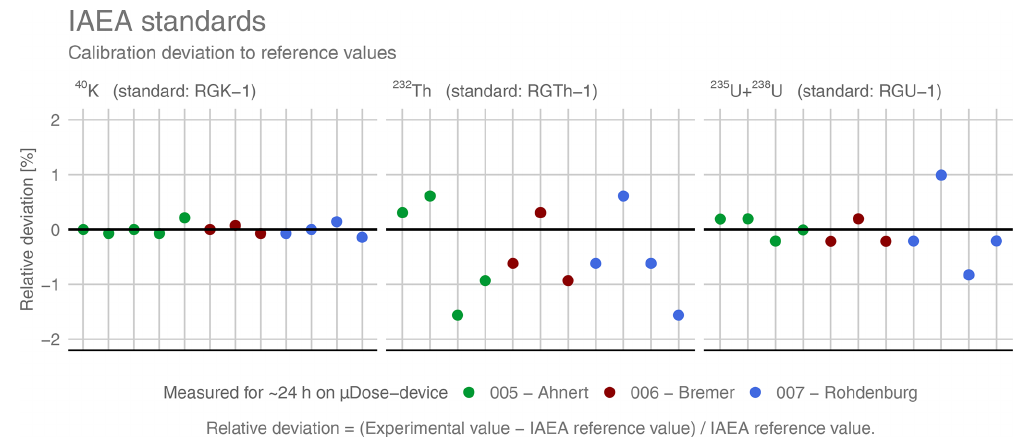
Figure 2. Results for repeated measurements of the investigated IAEA standards. The different colours of the symbols represent three different measurement devices (see legend). All plots show the relative deviation of measured values from the respective reference values provided for the IAEA standards. Sample RGK-1 is illustrated on the left, the thorium standard RGTh-1 is shown in the centre and RGU-1 is depicted on the right. Bold lines illustrate the 0% deviation (i.e. perfect agreement of measured and expected values). Please note that only activities arising from the dominant radioactive emitter of the respective standard were considered for this figure. Table 6. Accuracy and precision of µ Dose measurements of certified IAEA standards. The accuracy is expressed as measured-to-given ratios (MGRs). Precision is given as relative standard deviation (RSD) of measured activities. Only results derived for the dominant emitter of the respective IAEA standard were considered for this table. Radionuclide Measured-to-given ratios (MGRs) and relative standard deviations (RSDs) (IAEA standard) All devices Device Ahnert Device Bremer Device